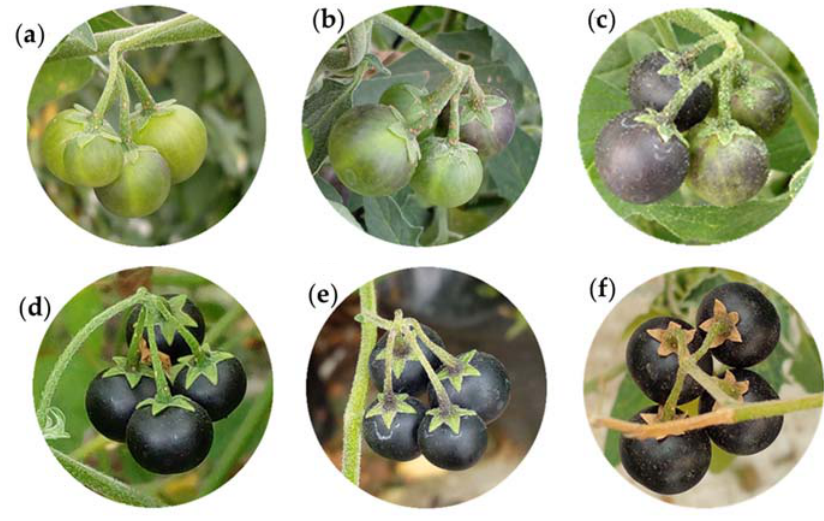
Figure 14. Fruit cluster of slender nightshade plants ( Solanum nigrescens ) with 10 ( a ), 30 ( b ), 50 ( c ), and 100% ( d ) purple pigmentation on the surface. The sepals are green-yellow ( e ) and withered ( f ). Photos by Sara Monzerrat Ramírez-Olvera.